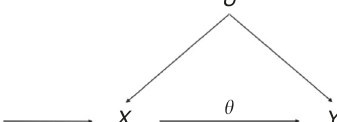
Fig. 2 Directed acyclic graph of instrumental variable assumptions made in multivariable Mendelian randomization. G = genetic variants, X j = risk factor j for j ¼ 1 ; ¼ ; d , Y = outcome, U = confounders, θ j = causal effect of risk factor j